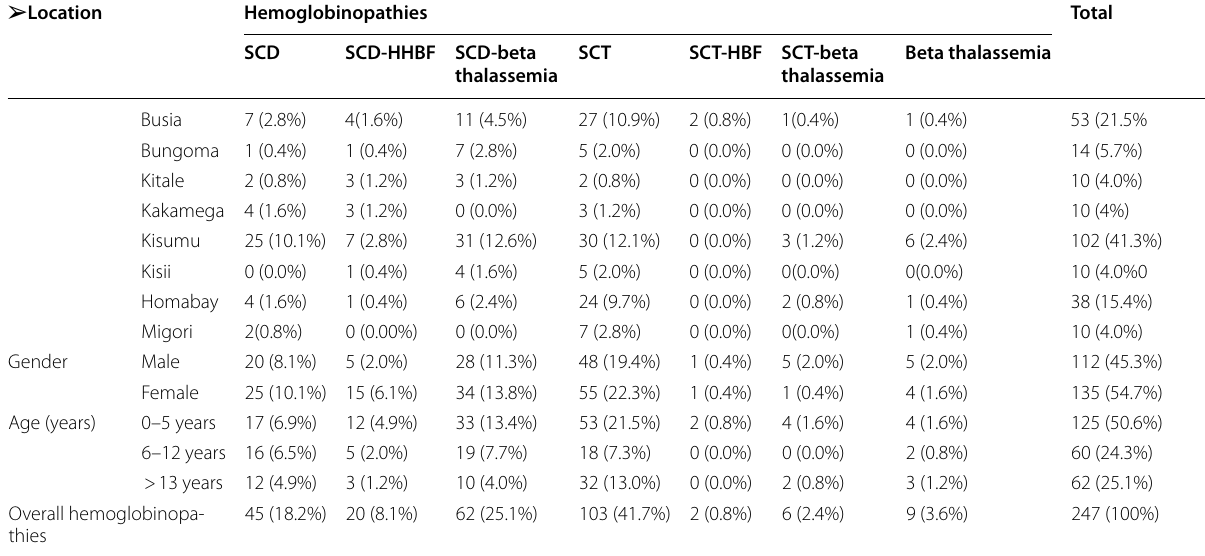
Table 1 Distribution of hemoglobinopathies among patients investigated at Aga Khan Hospital, Kisumu, in Kenya ➢